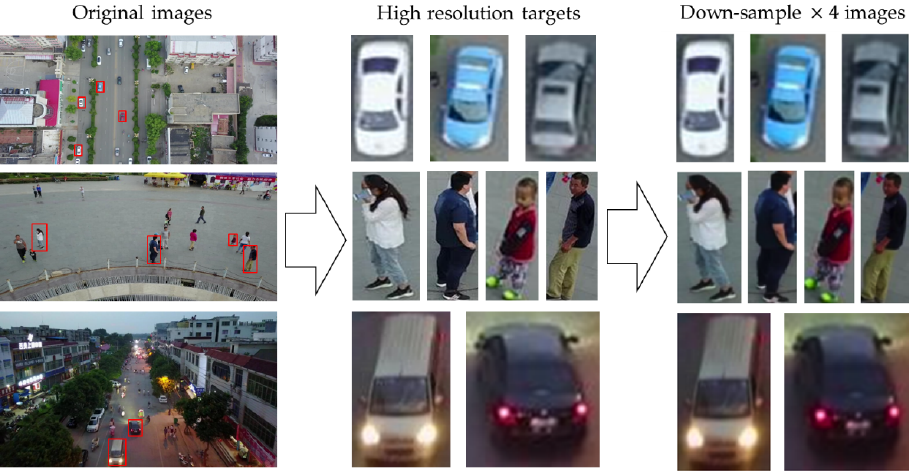
Figure 6. The sub-datasets we created for the Generative Adversarial Network (GAN) task to generate high resolution objects and down-sample